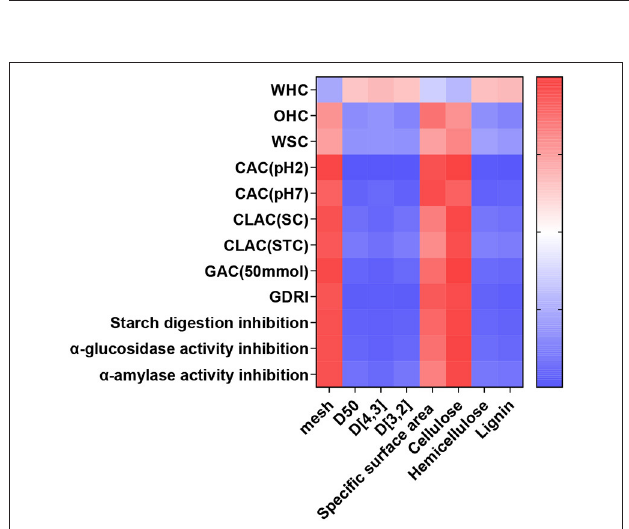
FIGURE 7 | Correlation between physical and functional properties of IDF from corn